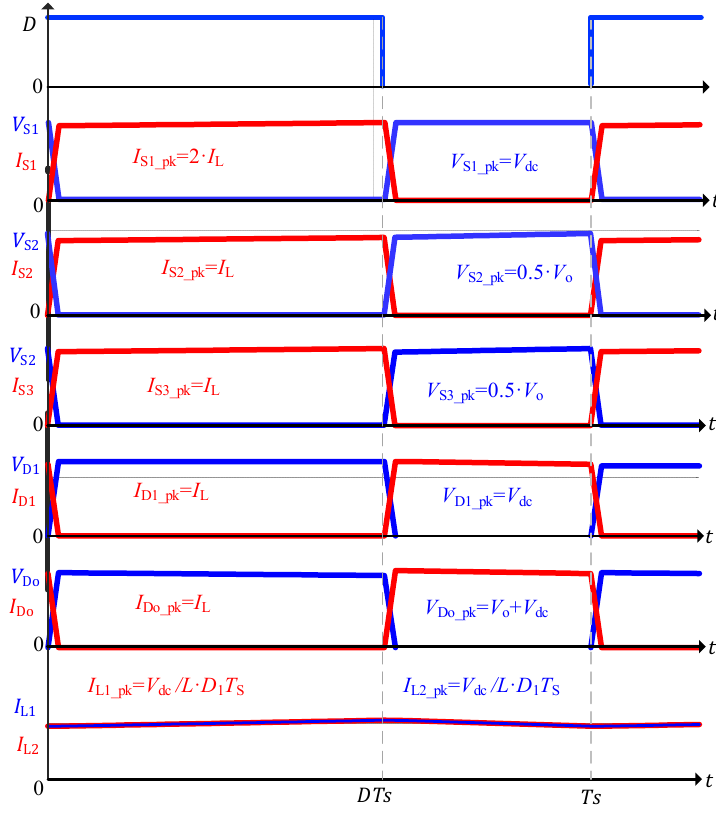
Figure 3. Typical converter waveforms in CCM.